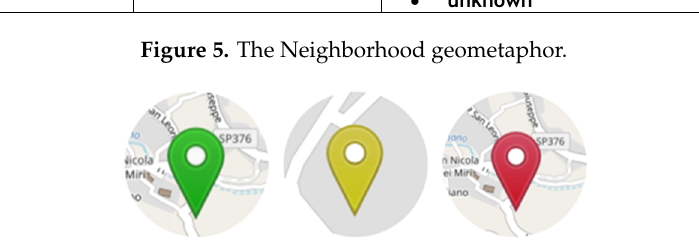
Figure 6. The Neighborhood state representation.